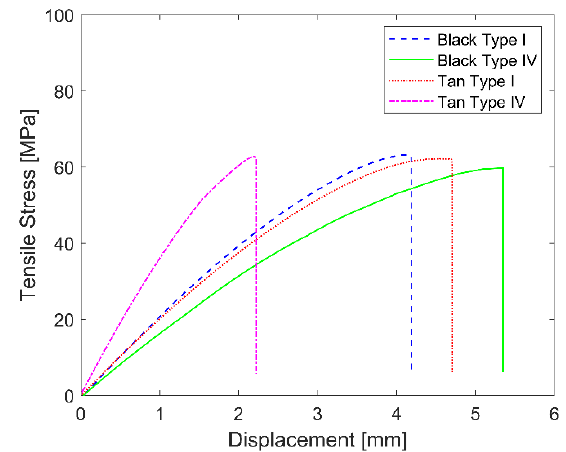
Figure 5. Average tensile stress versus displacement curves.